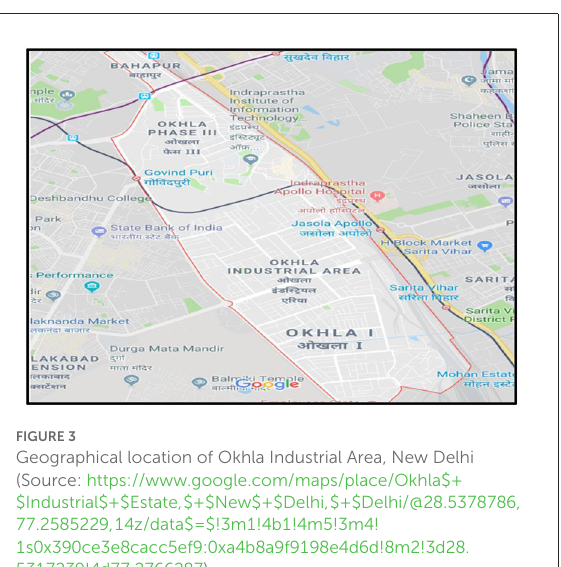
FIGURE2 Geographical location of Connaught Place, New Delhi